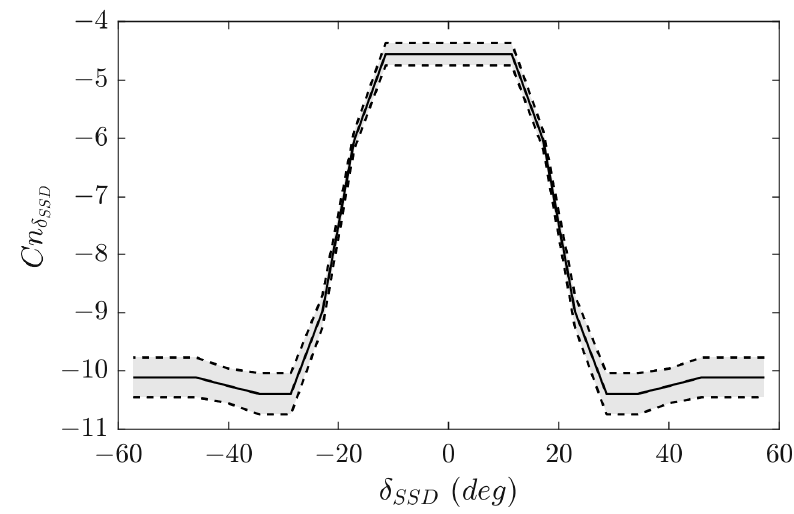
Figure 7. SSD yaw control moment derivative (per radian); the gray area is the continuous error bar for various angles of attack (angles of attack α = − 6~12 deg).